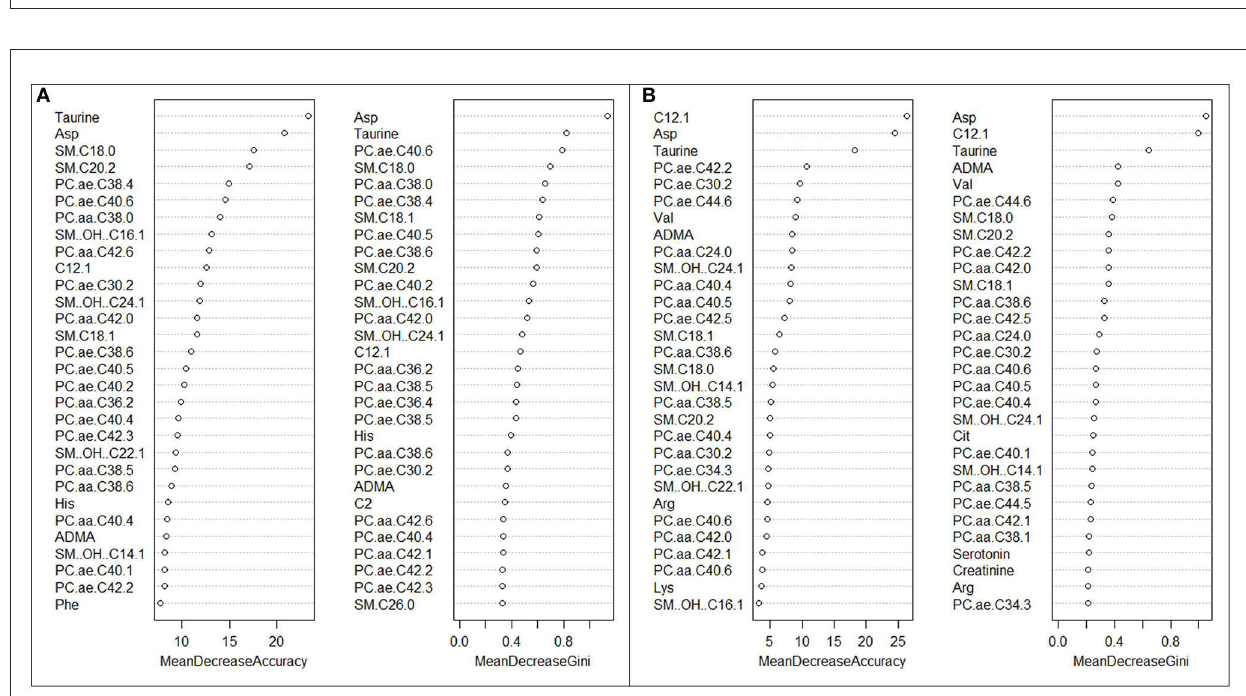
FIGURE2 (A, B) Variable importance scores plots of the 30 most important metabolites in predicting current vs. never night shift workers (A) and former vs. never night shift workers (B) , according to both Mean Decrease Accuracy and Mean Decrease